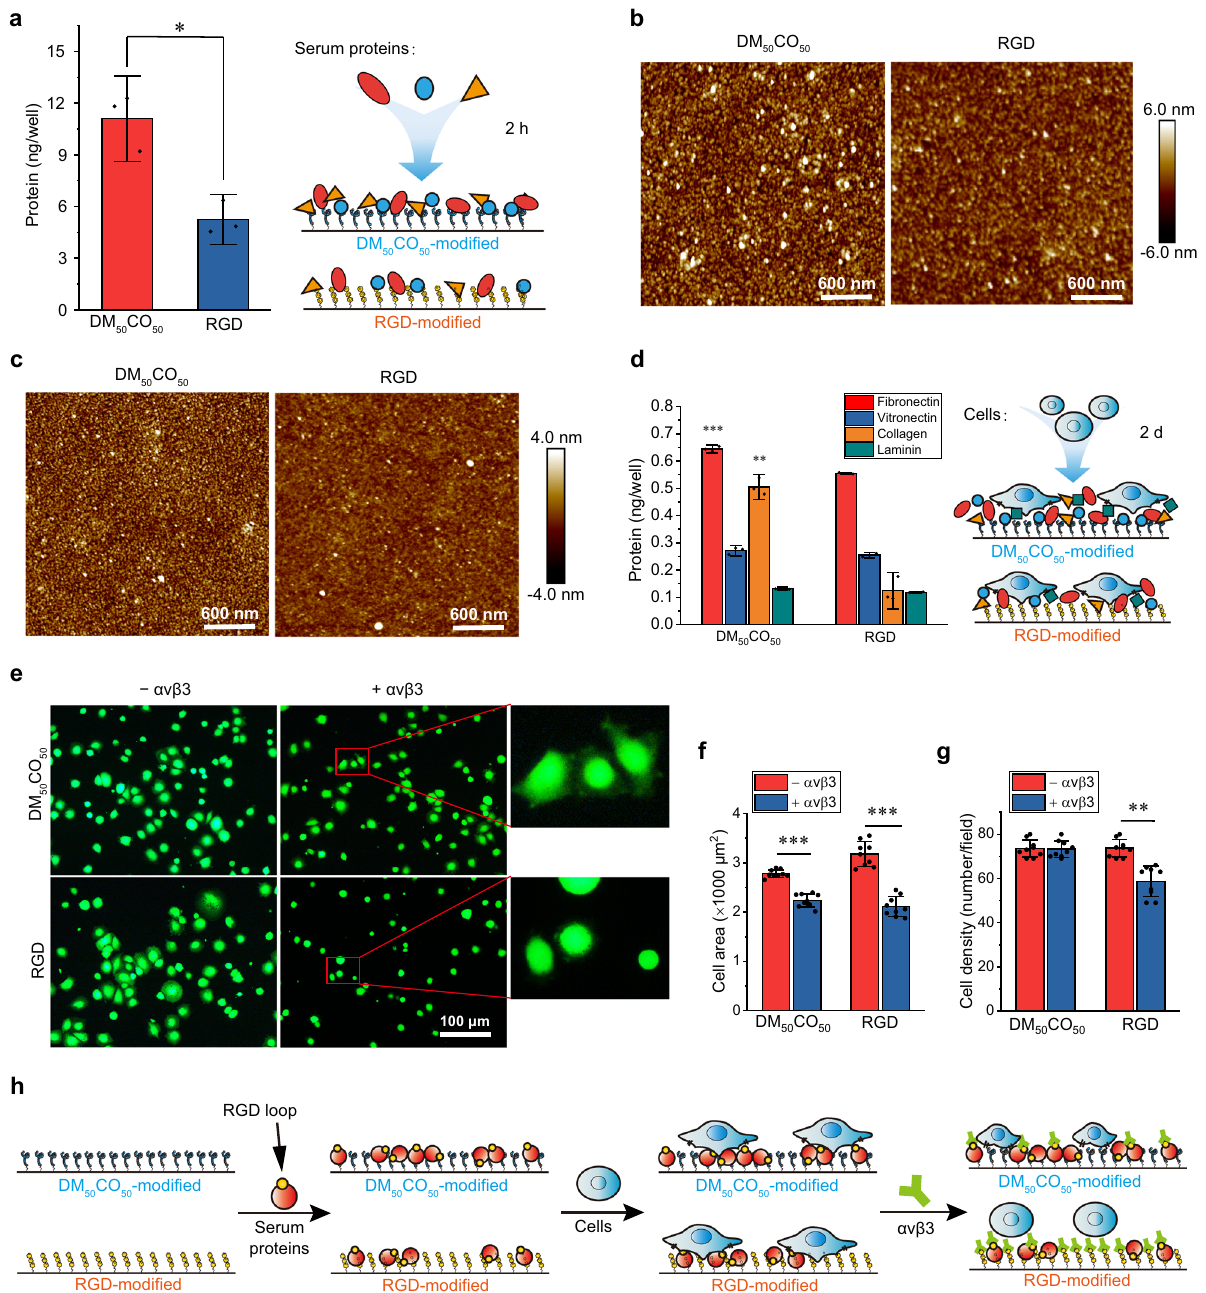
Fig. 5 Effect of adsorbed serum proteins on preosteoblast cell adhesion to DM 50 CO 50 -modi fi ed surfaces. a The amount of surface-adsorbed total protein after variable surfaces were incubated with a serum-containing cell culture medium for 2h. b , c AFM images of DM 50 CO 50 and RGD-modi fi ed surfaces after incubation with serum-containing cell culture medium ( b ) and pure fi bronectin ( c ) for 2 h. d The amount of surface-adsorbed individual protein ( fi bronectin, vitronectin, collagen, laminin) on DM 50 CO 50 and RGD-modi fi ed surfaces after cells were cultured on the surfaces for 2 days. Fluorescence micrographs of: e live/dead stained cells, f spreading area, and g density analysis, of cells 2 h after seeding on DM 50 CO 50 and RGD-modi fi ed surfaces, which were fi rst incubated with serum-containing medium and then treated with or without integrin α v β 3 before cell seeding. h Carton illustration of results in ( e – g ). Data in ( a , d , f , g ) represent mean ±s.d. ( n = 3 for a , d and n = 9 for f , g ). Statistical analysis: two-tailed t -test, ** p < 0.001, *** p < both RGD and KRSR, as a re fl ection of cell adhesion mechanism (dual mechanisms) different from either RGD or KRSR.